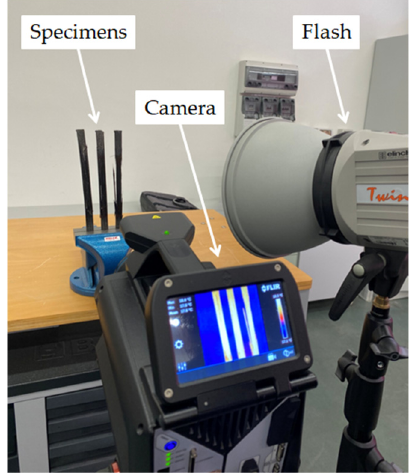
Figure 6. Flash thermography setup.